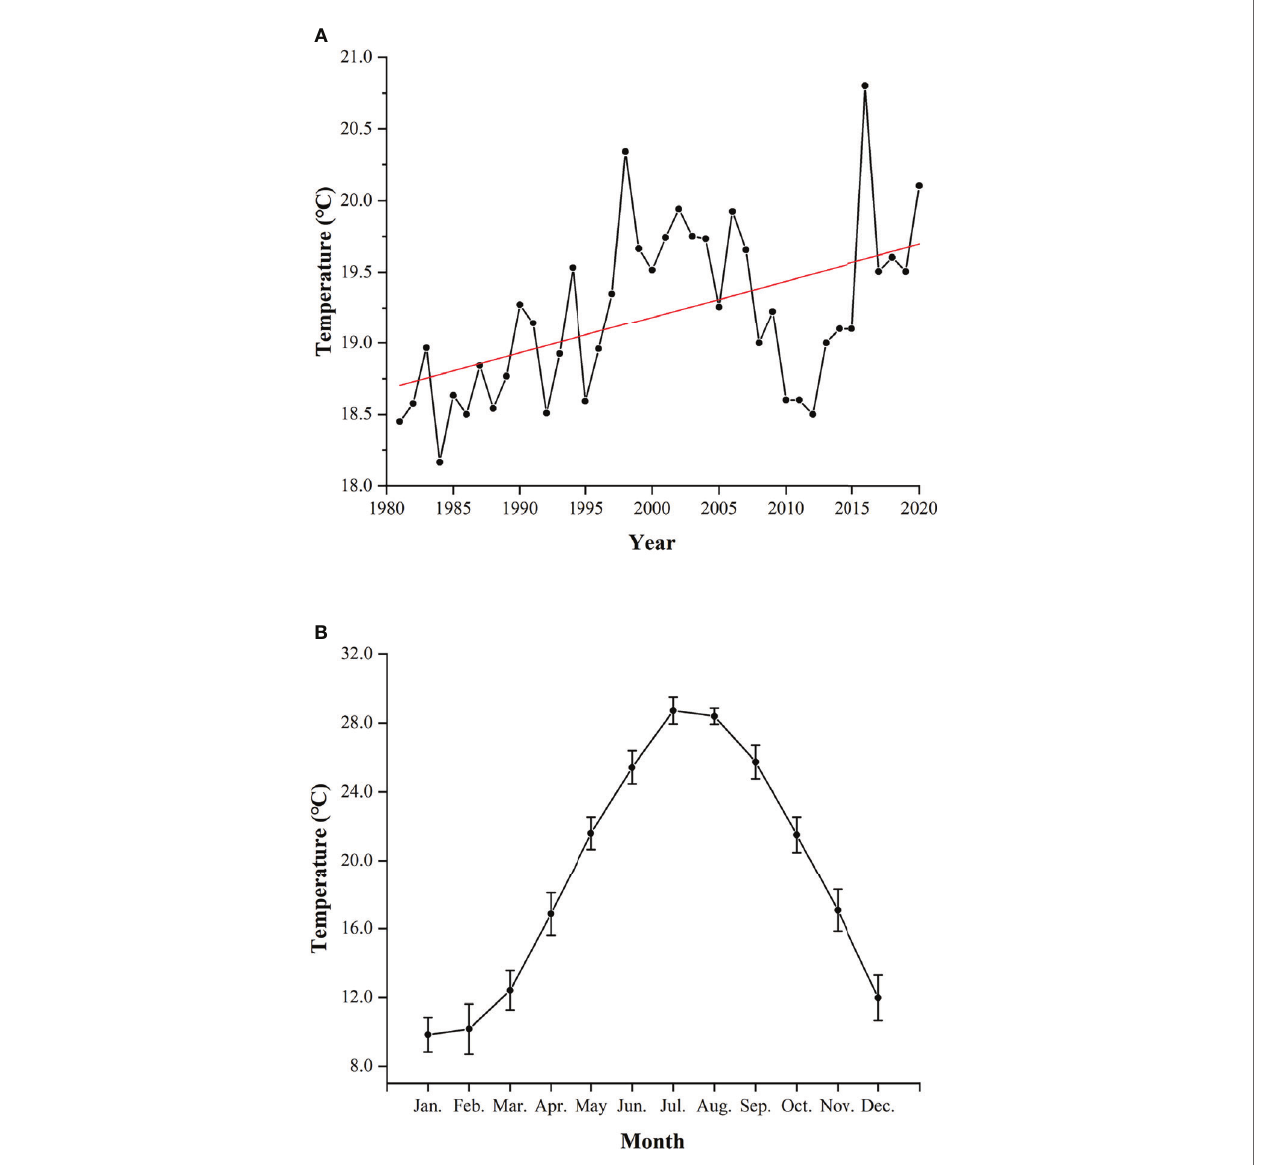
FIGURE 9 | Annual average temperature (A) and monthly average temperature (mean ± SD) (B) of Guanjingyang from 1981 to 2020 (Meteorology Bureau of Fujian Province, 1981 – 2010; Ningde Bureau of Statistics, 2011 – 2020). The red line indicates the fi tted linear equation: y = 0.025x - 31.51 (R 2 =